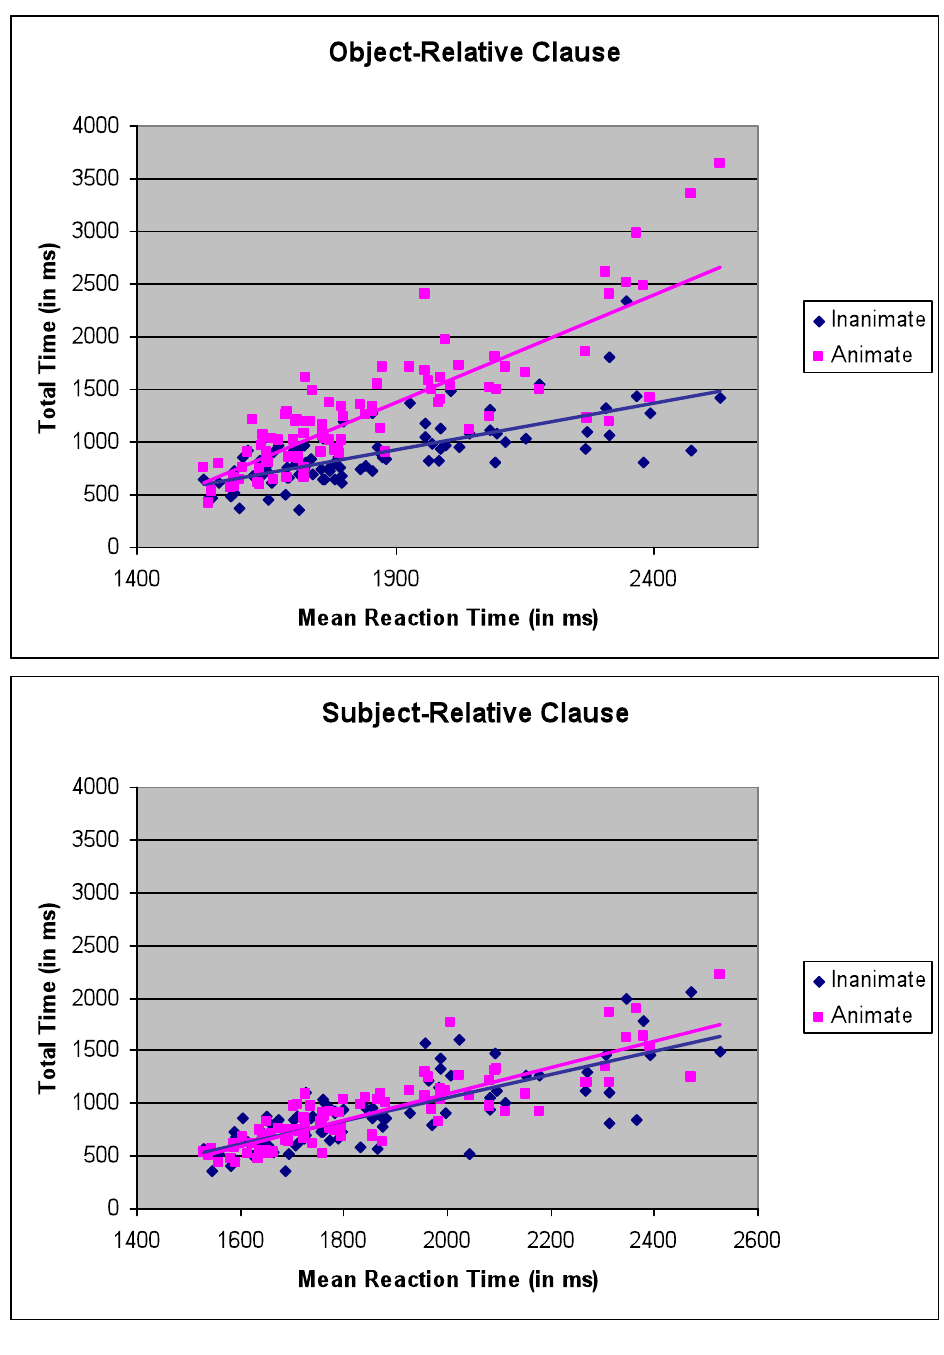
FIGURE 1: Mean total time for subject (top) and object relative clauses (bottom) for sentences with animate and inanimate subjects, plotted against average reading